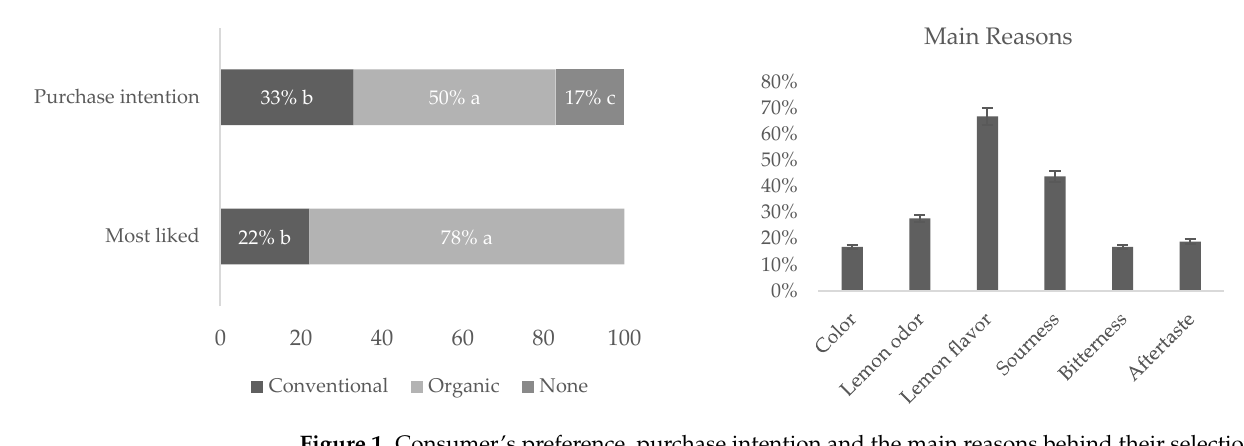
Figure 1. Consumer’s preference, purchase intention and the main reasons behind their selection of organic and conventional lemons. Factors with different letters were significantly different ( p < 0.05), Tukey’s least significant difference test.